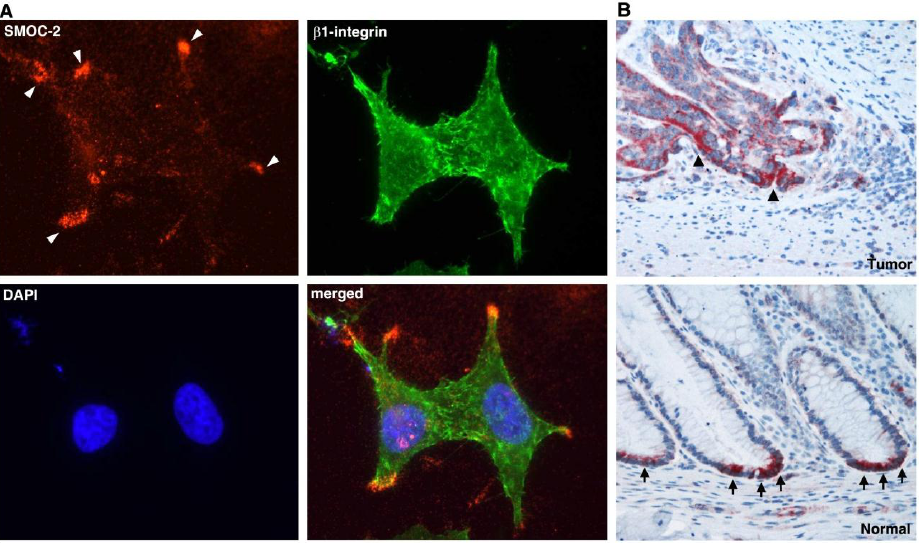
Figure 5. The localization of SMOC-2 (secreted, modular, matricellular, Ca 2+ -binding protein 2) in cultured CRC cells and in CRC tissue. ( A ) SMOC-2 is localized outside the cells at the tip of cellular protrusions (white arrowheads); ( B ) CRC tissue was strongly stained for SMOC-2 (black arrowheads) at the more invasive areas of the tumor, while normal colonic epithelium displayed SMOC-2 staining exclusively at the bottom of colonic crypts (black arrows), suggesting that SMOC-2 is expressed by colonic stem cells (modified from reference